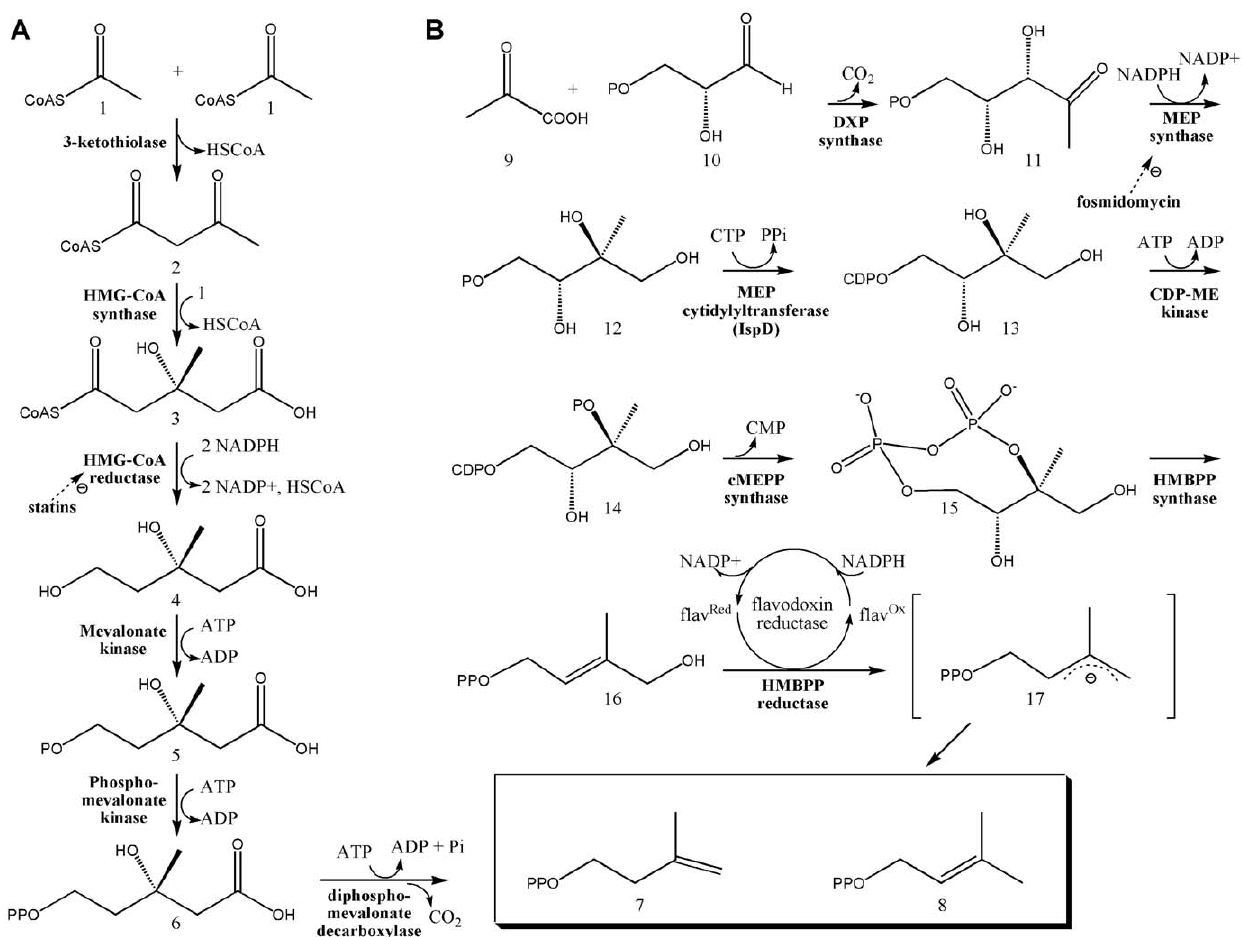
Figure 1. Two pathways of isoprene biosynthesis. A) The MVA Pathway. Three molecules of acetyl-CoA (1) are condensed to form 3-hydroxy-3- methylglutaryl CoA (HMG-CoA) (3), which is then reduced to MVA by HMG-CoA reductase (4) [20,21]. MVA is further processed to yield IPP (7) [22–24], which is converted to DMAPP (8) by an isomerase [25]. B) The MEP Pathway. Pyruvate (9) is condensed with glyceraldehyde 3-phosphate (10) to yield 1-deoxy-D-xylulose 5-phosphate (DXP; (11)) [26], an intermediate with a role in E. coli vitamin B1 and B6 biosynthesis [27–30] as well as isoprene biosynthesis. 1-Deoxy-D-xylulose 5-phosphate reductoisomerase (also called MEP synthase) catalyzes the reduction and rearrangement of 11 to yield MEP (12) [31], the first committed step in the E. coli MEP pathway. The next enzyme, MEP cytidylyltransferase (or IspD), converts MEP into 4-(cytidine 5 9 -diphospho)-2-C-methyl-D-erythritol (CDP-ME; (13)). CDP-ME kinase then phosphorylates CDP-ME, which becomes cyclized (coupled with the loss of CMP) by cMEPP synthase to yield 2-C-methyl-D-erythritol 2,4-cyclodiphosphate (15) [14,32–35]. A reductive ring opening of 15 produces 1- hydroxy-2-methyl-2-butenyl diphosphate (HMBPP; (16)) [36–40], which is reduced to both IPP and DMAP in a , 5:1 ratio [4,41–46].